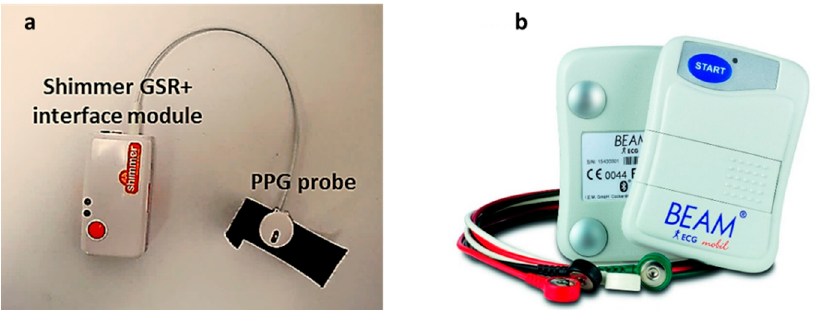
Figure 3. ( a ) the shimmer Optical Pulse sensing probe (PPG sensor) and data-logger, ( b ) and the ECG recorder, BEAM ® , used to record ECG signals from the pig as a gold standard for heart rate.